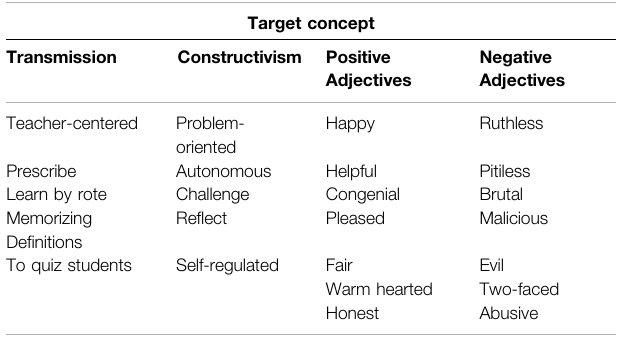
TABLE 2 | Stimuli used in ST-IAT transmission and ST-IAT